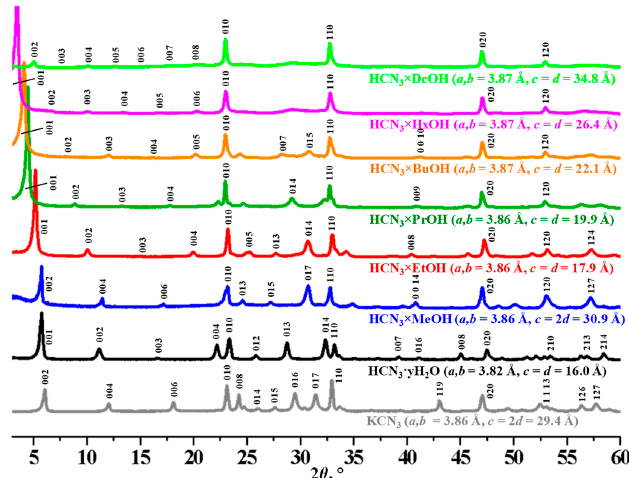
Figure 1. XRD patterns of the initial niobates and n -alkoxy derivatives.